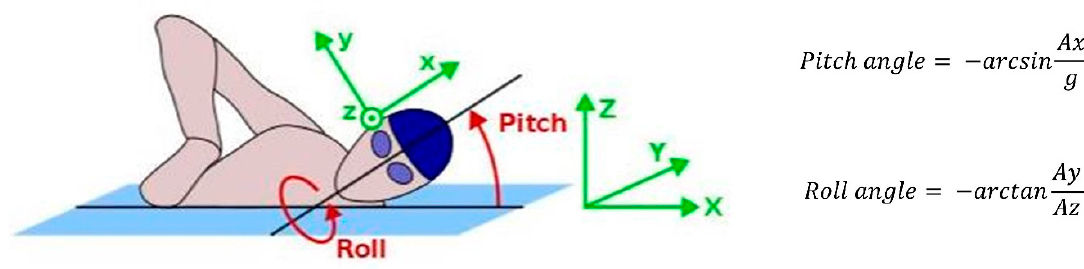
Figure 22. Determination of pitch and roll angles using a head mounted sensor. Reproduced with permissions from Pansiot, Lo and Yang [44].